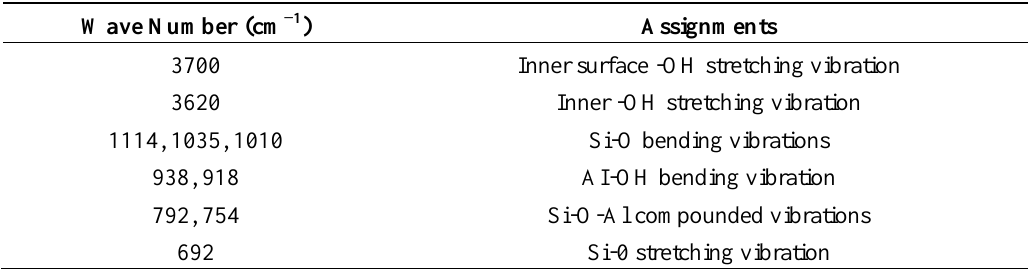
Table 2. Band assignments for kaolinite soil